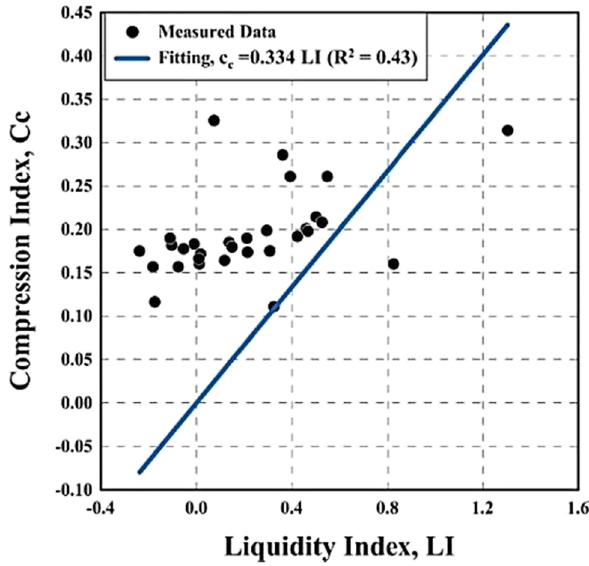
Figure 19: Compression index versus LI